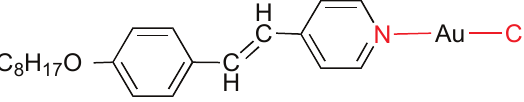
Figure 25. Gold mesogen containing stilbazol.